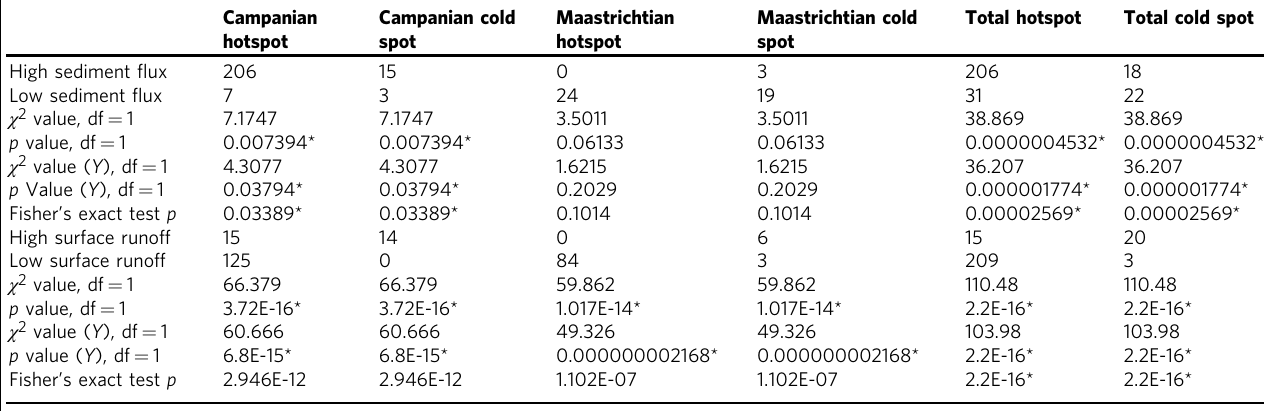
Table 2 Virtual taphofacies values with statistical support for the χ 2 value of Pearson ’ s chi-squared and Fisher ’ s tests of association with ( Y ) and without Yates ’ correction, showing which virtual taphofacies is signi fi cantly associated with a higher number of occurrences (in Campanian, Maastrichtian, and total latest Cretaceous hotspots) Campanian